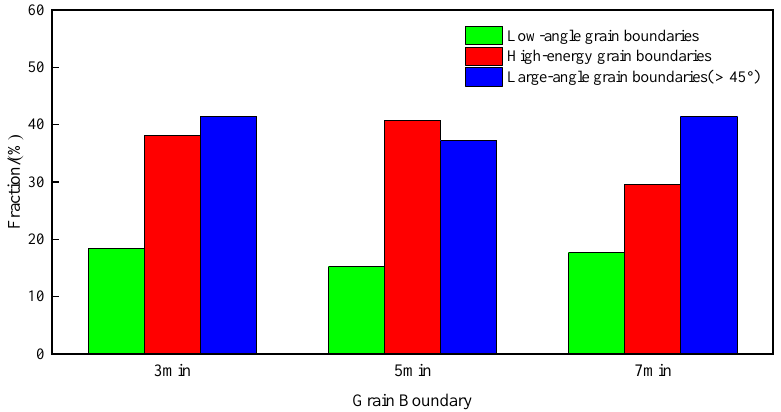
Figure 5. Fract i on of grain boundaries of decarbonized annealing samples along the thickness di- rection.